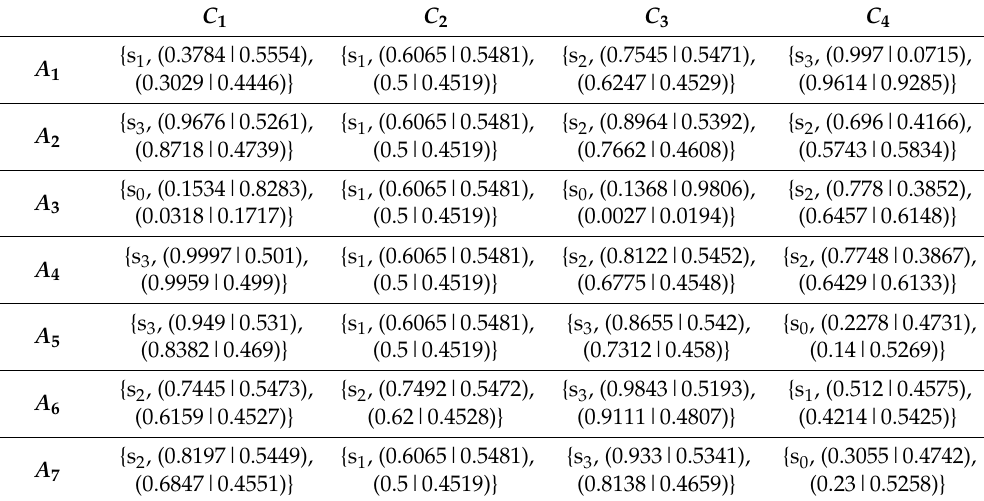
Table 13. Hesitant probabilistic fuzzy linguistic decision